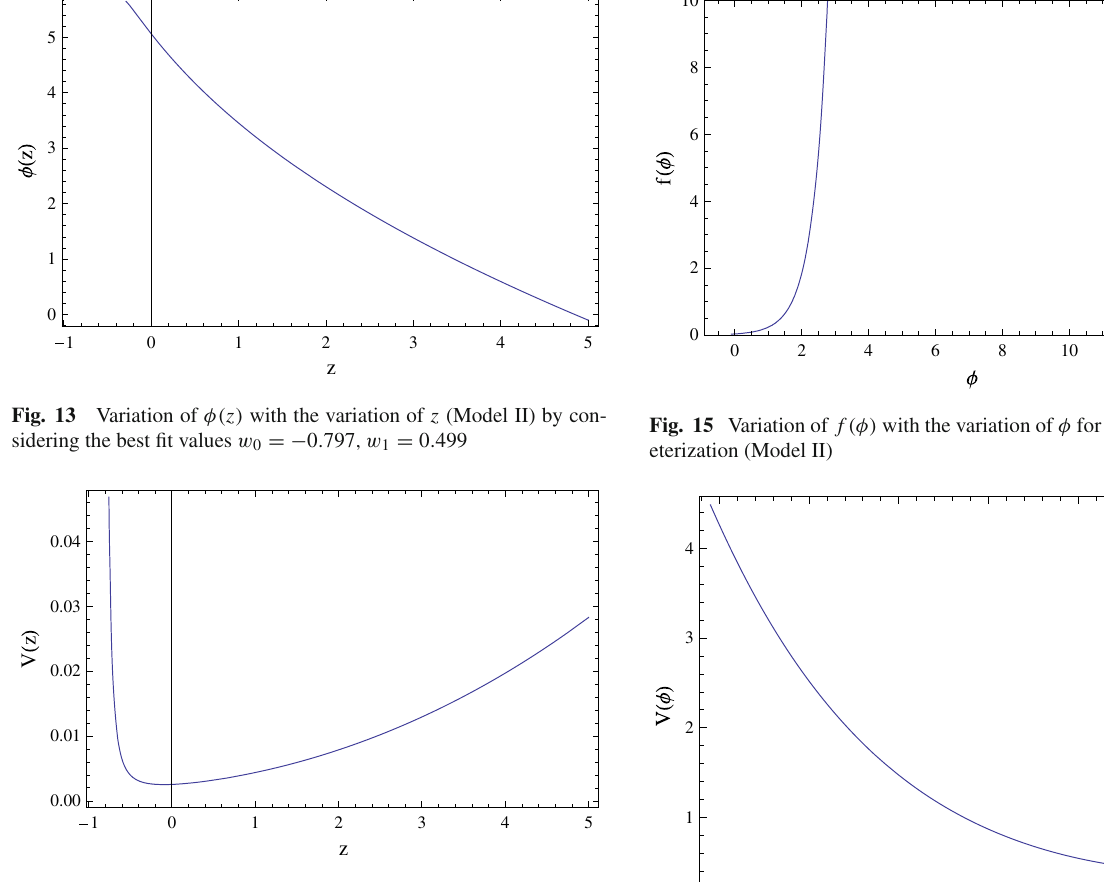
Fig. 14 Variation of V ( z ) with the variation of z (Model II) by con- sidering the best fit values w 0 = − 0 . 797 ,w 1 = 0 . 499